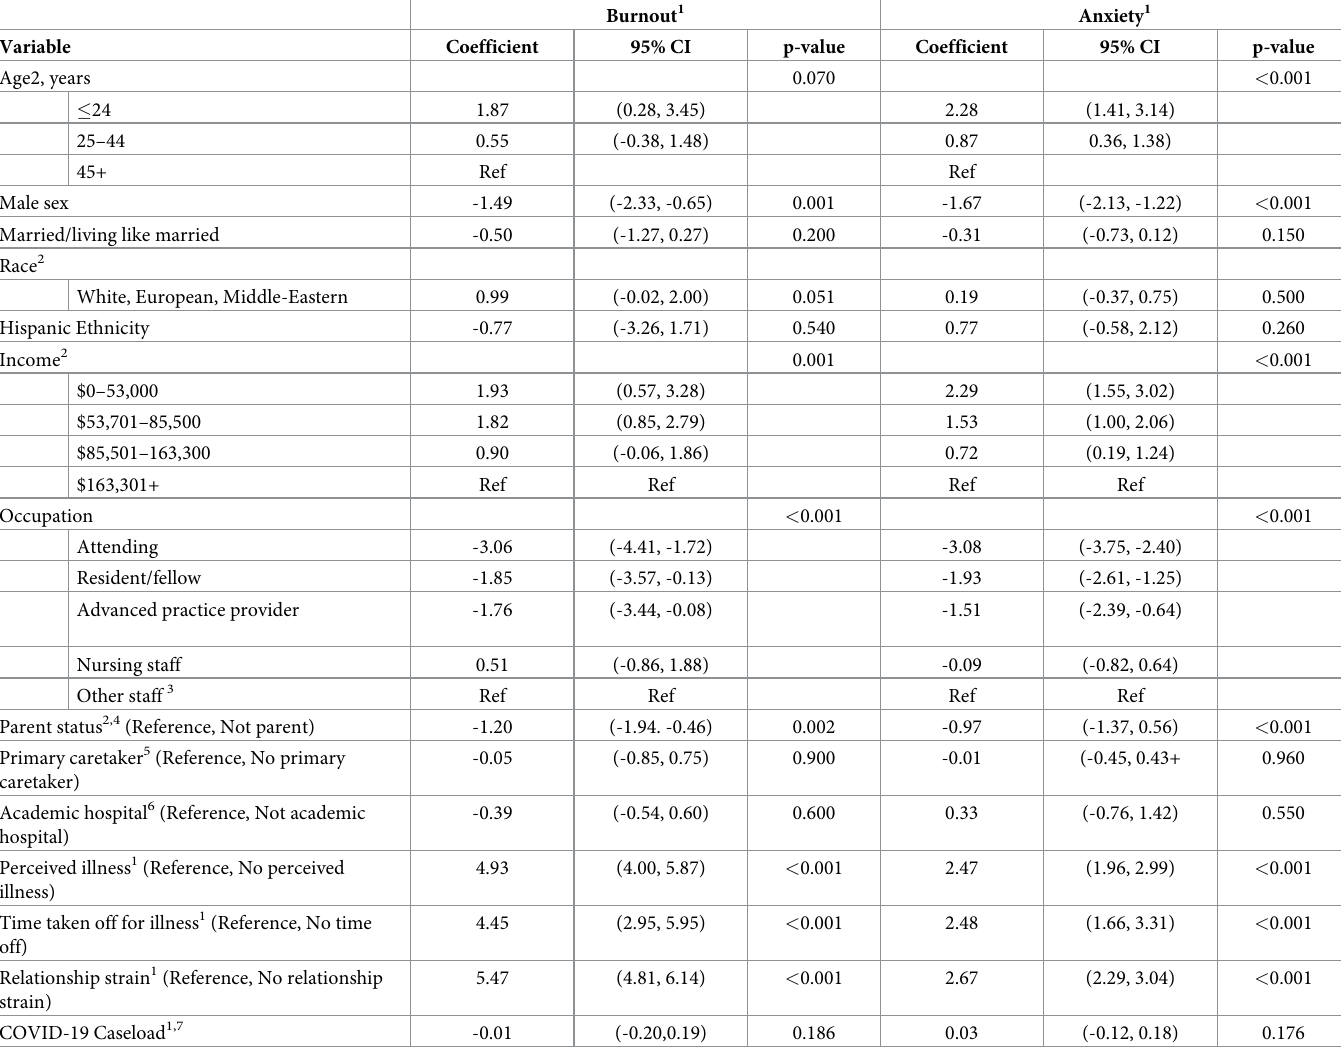
Table 2. Univariate associations between variables and outcomes of interest in the primary cohort (N =